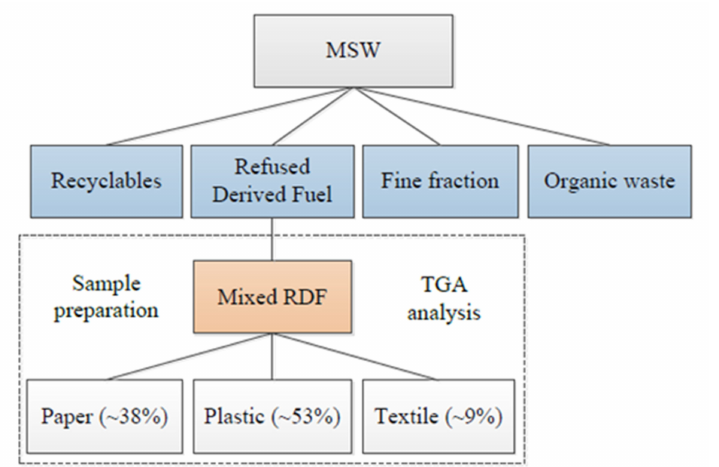
Figure 2. Procedure for sampling of RDF and its constituent components.